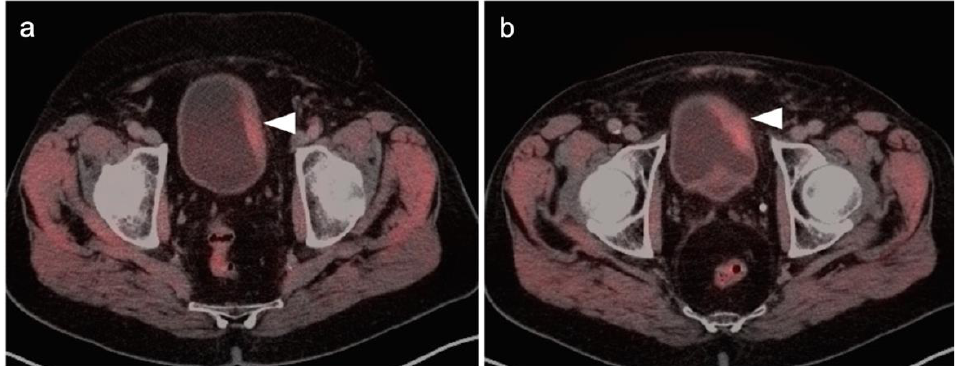
Figure 37. [ 18 F]-Fluciclovine PET-CT demonstrates PET-positive left-sided bladder wall thickening ( a , b , white arrowheads), biopsy-proven urothelial carcinoma.